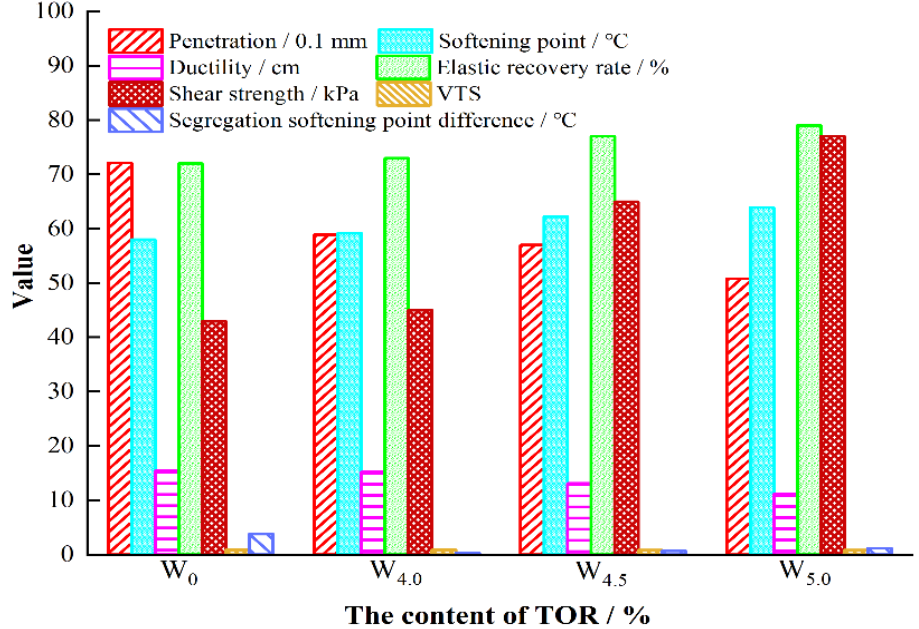
Figure 12. Performance indexes of crumb rubber modified asphalt with different TOR content.